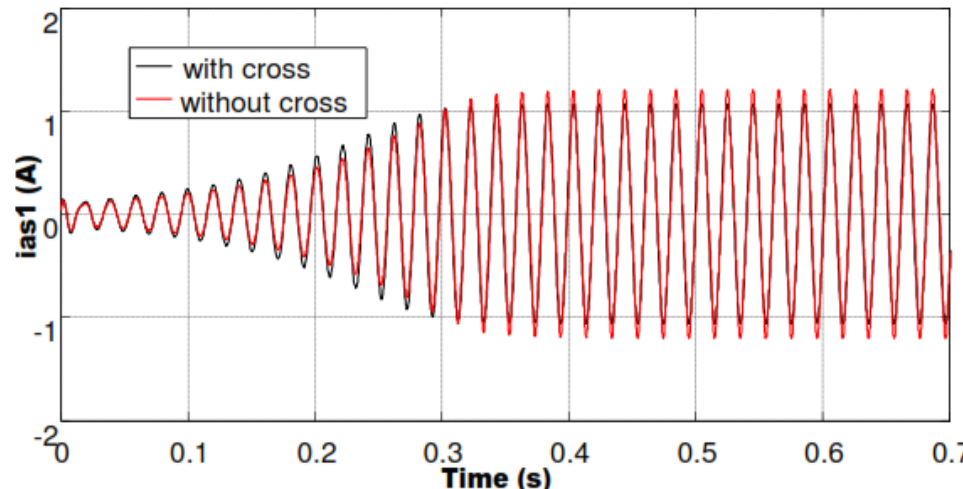
Figure 8. Simulation of the stator current ias1 with and without cross-saturation.